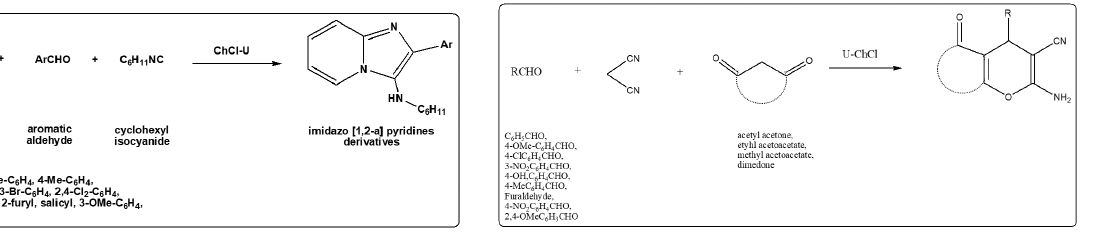
Figure 18: The synthesis of imidazo [1,2-a] pyridines derivatives from 2-amino pyridine catalysed by DES. m m